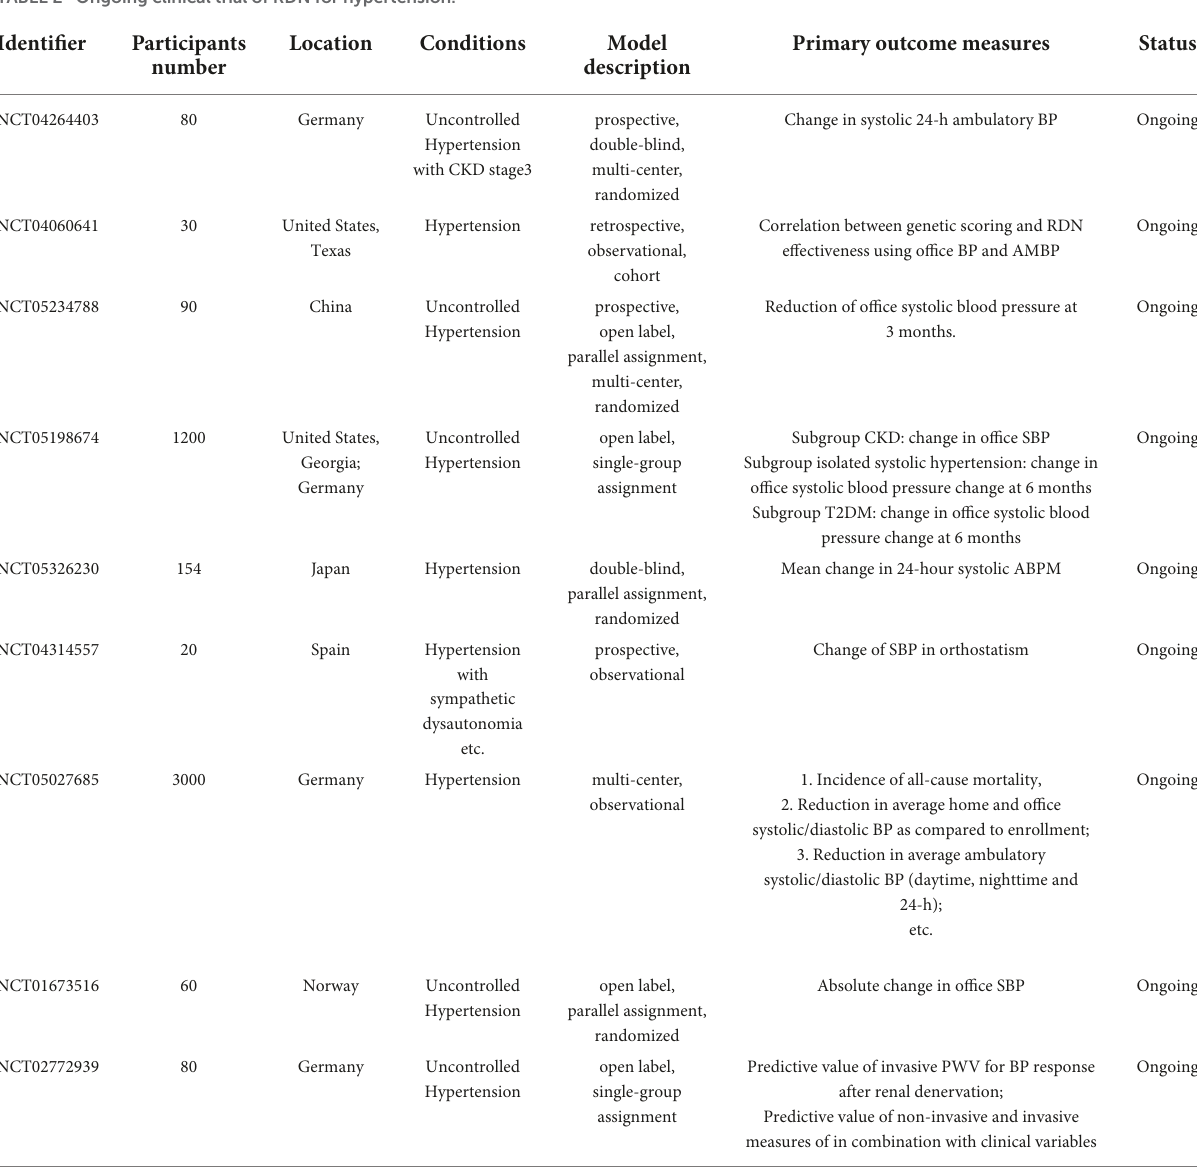
TABLE 2 Ongoing clinical trial of RDN for